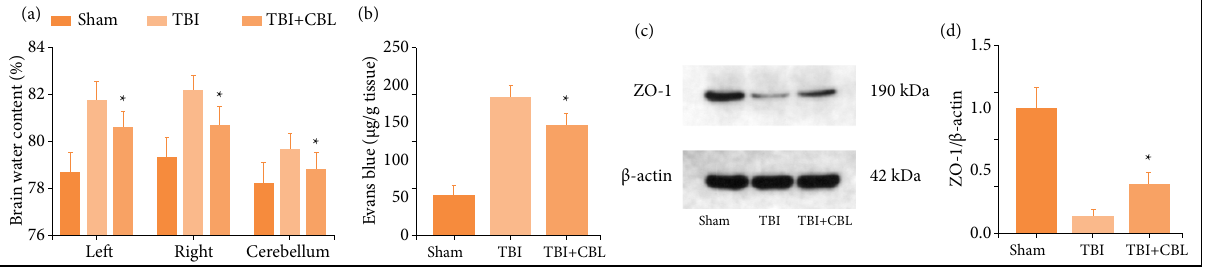
Figure 2 - CBL alleviates brain edema and BBB permeability after TBI. (a) CBL alleviates brain water content after TBI. (b) CBL alleviates BBB permeability after TBI. (c) Expression of ZO-1 in the brain cortex of mice after TBI was determined by Western blotting. (d) Quantification of ZO-1 in the brain cortex compared to the β-actin loading control. CBL increased ZO-1 expression after TBI in mice (n = 6; ANOVA; mean ± SEM). Cerebrolysin alleviates neuronal apoptosis after traumatic brain injury The TUNEL assay results revealed more hippocampal neuronal death after TBI, and CBL decreased neuronal apoptosis (Fig. 3a).